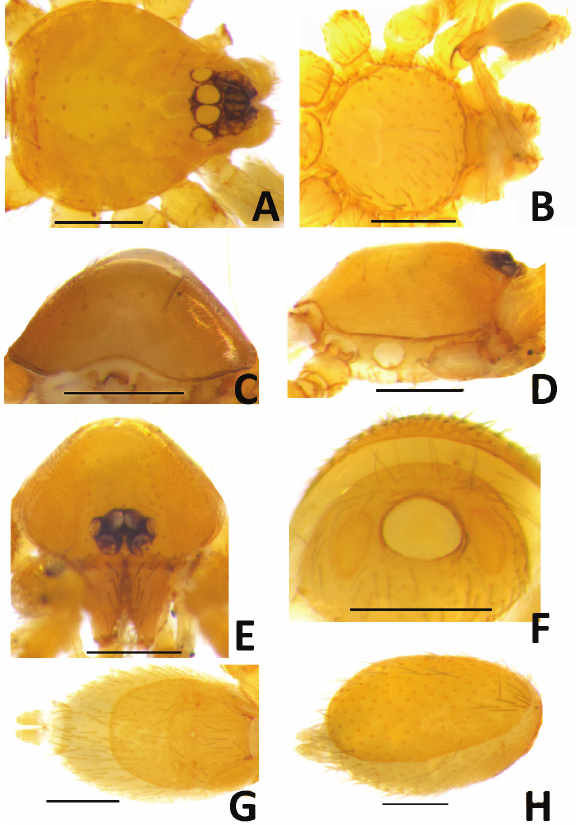
Figure 14. Pelicinus tumpy n. sp., male from Mihinthale FR: A , carapace, dorsal view; B , sternum, ventral view; C , carapace, posterior view; D , same, lateral view; E , same, anterior view; F , abdomen, anterior view; G , same, ventral view; H , same, dorsal view. Scale bars: 0.2